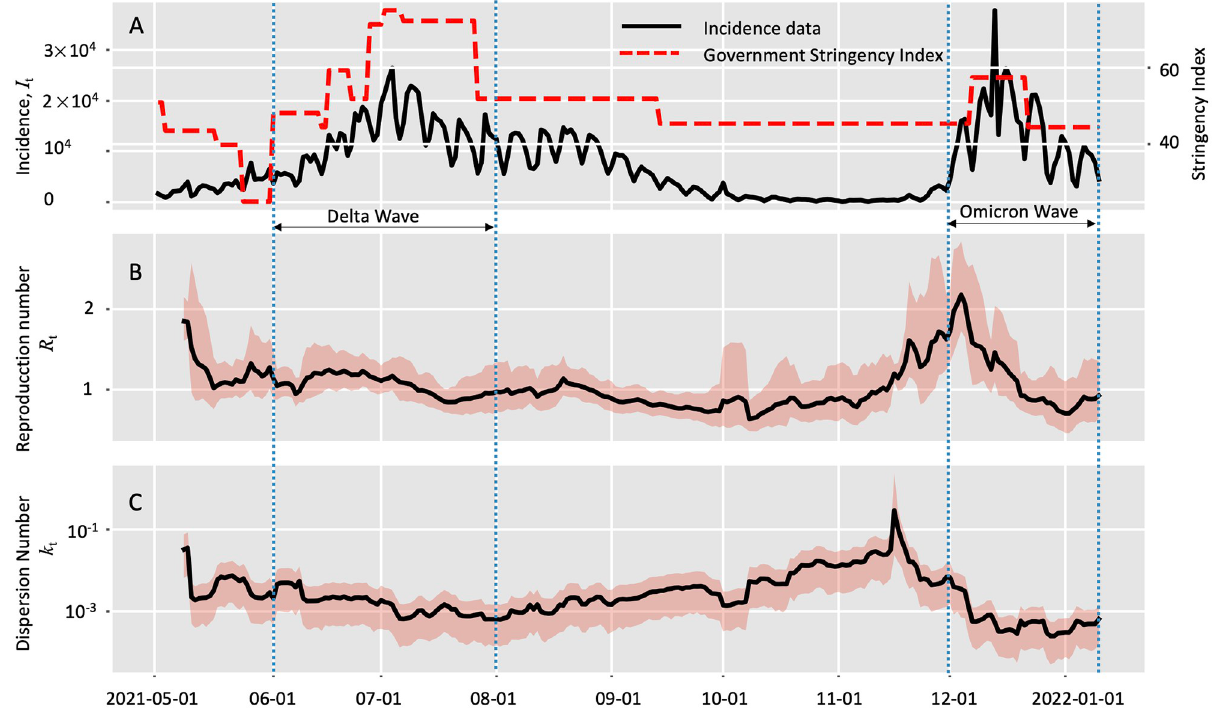
Fig 7. Estimation of real-time transmission dynamics of the COVID-19 epidemic between 2021-05-01 and 2022-01-09 in South Africa. Transmission dynamics (i.e., reproduction number R and dispersion number k ) were assumed constant over a window of 7 days, and the estimates were obtained by analyzing the incidence data of the time window. Solid lines show the mean estimates and the shaded areas show the 95% high probability density (HPD) intervals. A: Incidence data of the confirmed cases and government stringency data in South Africa; B: Estimation of reproduction number ( R ); C: Estimation of dispersion number ( k t t